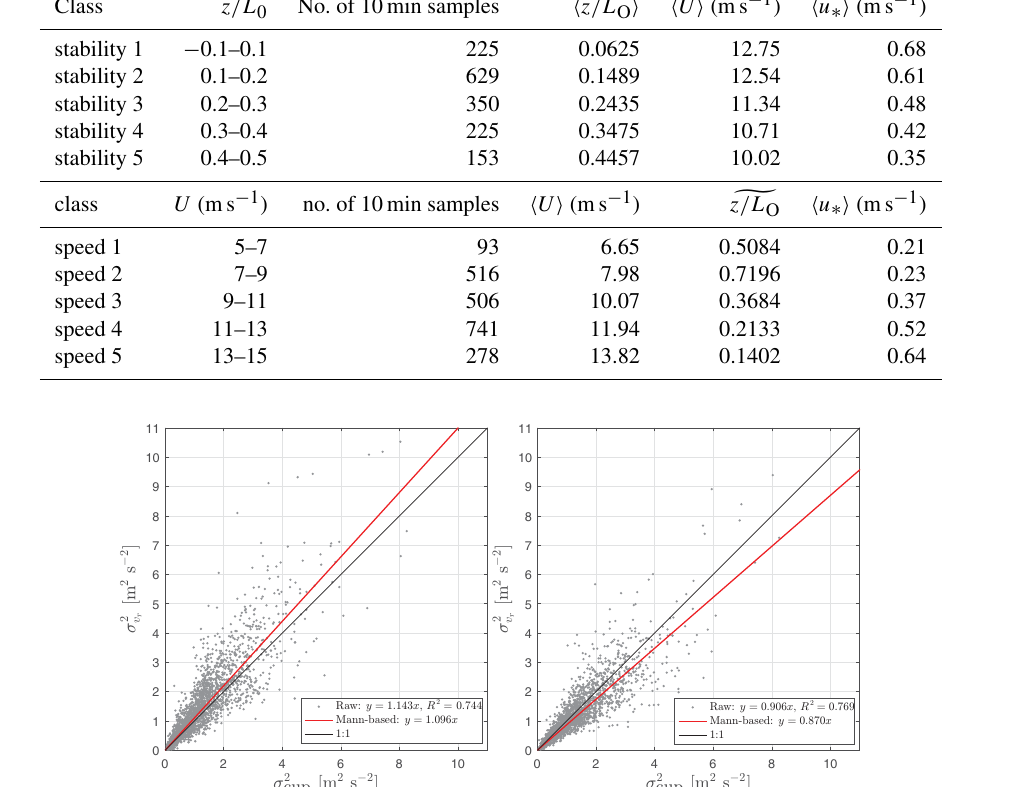
Figure 14. Comparison of the 80m cup-anemometer and the unfiltered ZephIR radial velocity variances for bins 0 (left) and 31 (right). We Figure14.Comparisonofthe80-mcup-anemometerandtheunfilteredZephIRradialvelocityvariancesforbins0(leftframe)and31(right show a 1:1 line for guidance and the predictions of the Mann model using (cid:48) = 3. Results of a linear regression through the origin and R 2 frame).Weshowa1:1lineforguidanceandthepredictionsoftheMannmodelusing Γ=3 .Resultsofalinearregressionthroughtheorigin and R 2 arealsogiven.Forbin31, σ 2 v m 2 s − 2 fortwo10-minperiods > 11m 2 s − 2 for two 10min periods. are also given. For bin 31, σ 2 v r > 11 r (filtered) radial velocity variances for these two bins are 13% and 31% lower than the cup-anemometer measurements (not shown)withslightlyhigher R 2 -values,0.785and0.798,respectively. Mann-model results predict biases of 11 and − 13 % for bins Further, we can also estimate σ 2 and u (cid:2) w (cid:2) for each 10-min period through a least-squares fit of Eqn. (10), that does not u,v,w 0 and 31, respectively (not shown). It is important to mention depend on the Mann parameters but assume homogeneous turbulence within the scanned volume, using the unfiltered radial basedontheunfilteredradialvelocityvariancesofallbinswithout 5 velocityvariances.Figure15-leftshowstheestimateof σ 2 that the original (filtered) radial velocity variances for these u accounting for misalignment compared to σ 2 cup . The lidar-variance estimate is only 2% larger than the cup-anemometer value two bins are 13 and 31 % lower than the cup-anemometer measurements (not shown) with slightly higher R 2 values, 0.785 and 0.798, In Fig. 15-right we show a similar comparison to the plot in the left panel but for the ‘filtered’ u -variance, which was computed by reconstructing the u - and v -components, as described in Sect 5.4, using the ZephIR measurements on the seven 10 bins, but from the 18-s radial velocity measurements. The comparison with the filtered values shows poor agreement with a 50% underestimation of the variance by the ZephIR. However, reconstructed u -velocities from the 18-s radial velocities and averaged within 10-min periods compare well with the reconstructed values from the 10-min means; the mean bias is 0% and R 2 =0 . 999 (notshown).